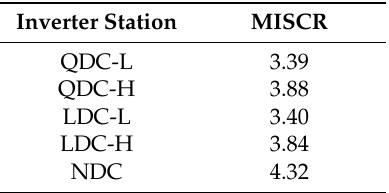
Table 4. MISCR of Each Inverter Station before Optimization.